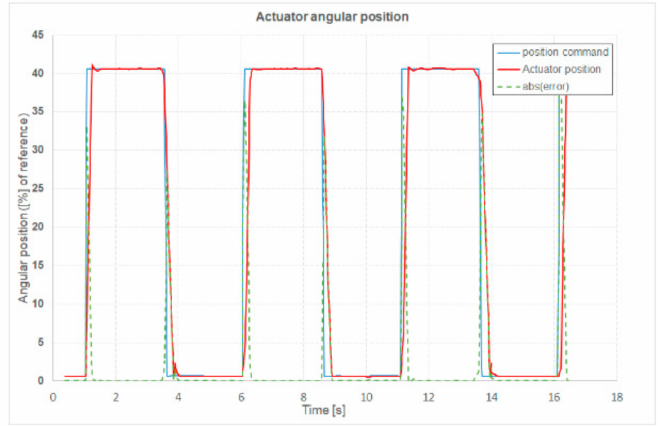
Figure 18. Position response using master / slave method.